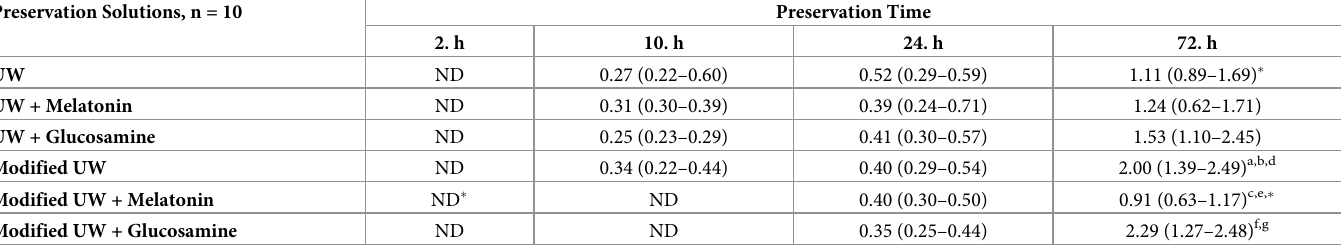
Table 3. LDH activity (IU/g wet tissue) was measured from six different preservation solutions at 2, 10, 24, and 72 h of preservation time. Data are given as a median and interquartile range